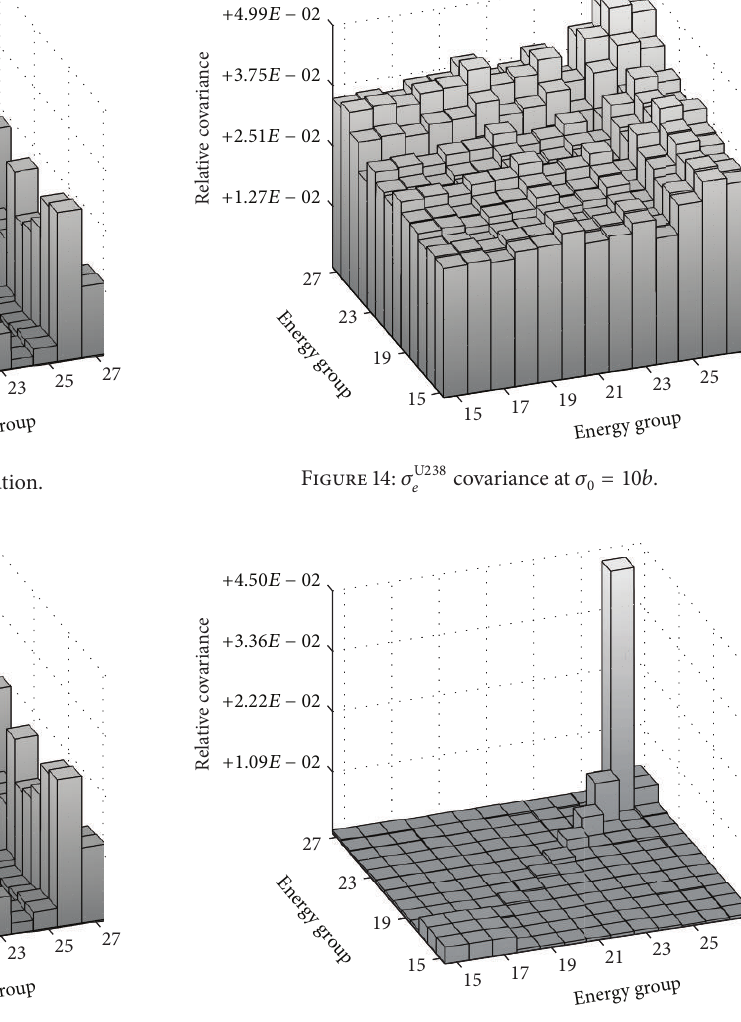
Figure 15: 𝜎 U 235 𝛾 covariance at infinite